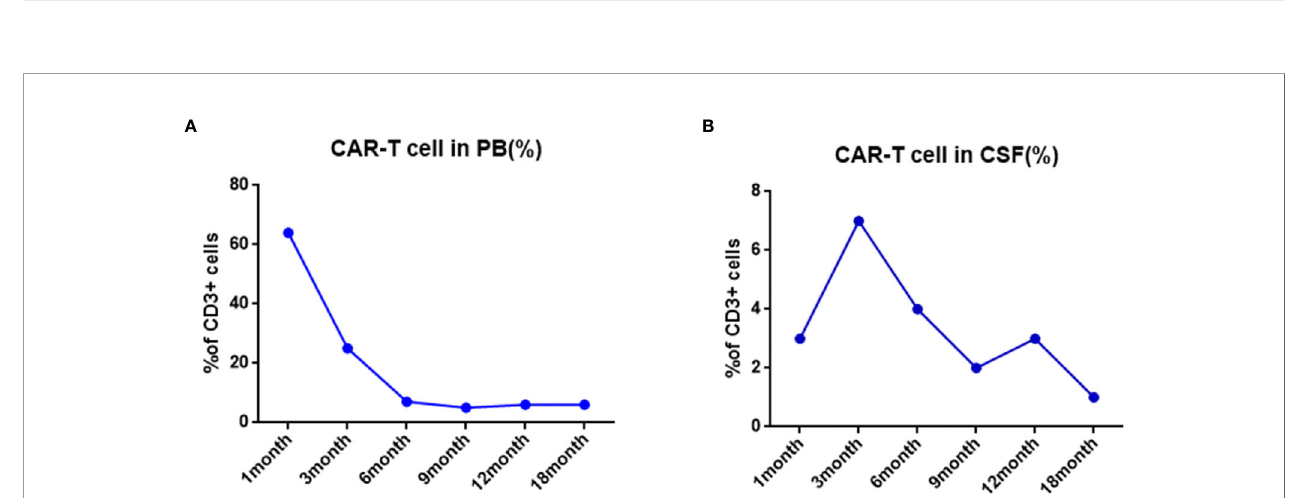
FIGURE 4 | Changes of total CART percent after CAR-T treatment. (A) The proportion of CAR-T cells in CD3 positive T cells was detected by fl ow cytometry in PB. (B) The proportion of CAR-T cells in CD3 positive T cells was detected by fl ow cytometry in